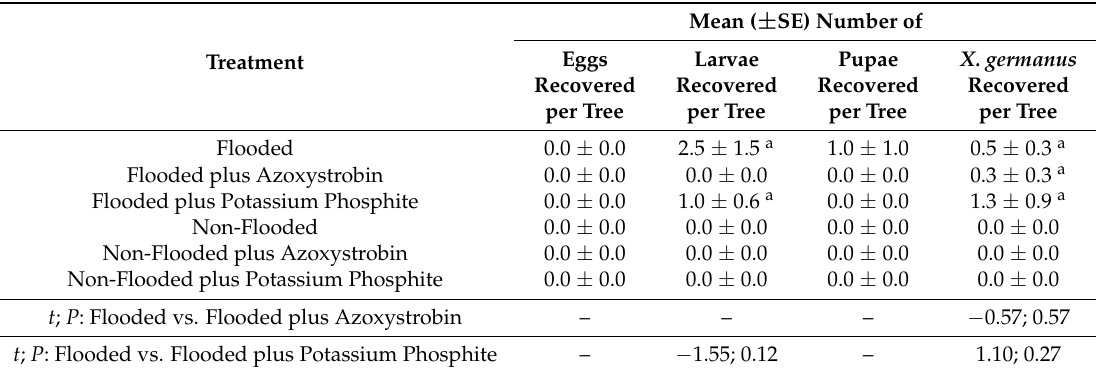
Mean ( ± SE) Number of